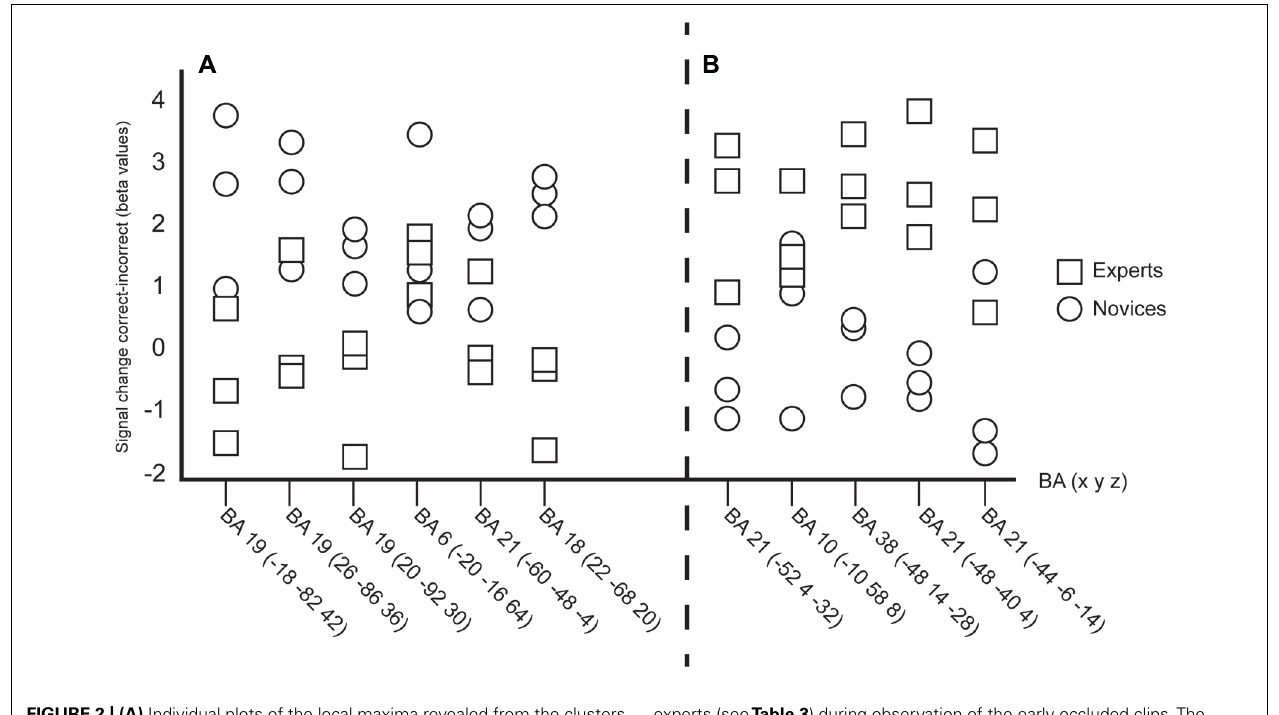
FIGURE 2 | (A) Individual plots of the local maxima revealed from the clusters by the novices (see Table 1 ) during observation of the early occluded clips. (B) Individual plots of the local maxima revealed from the clusters by the